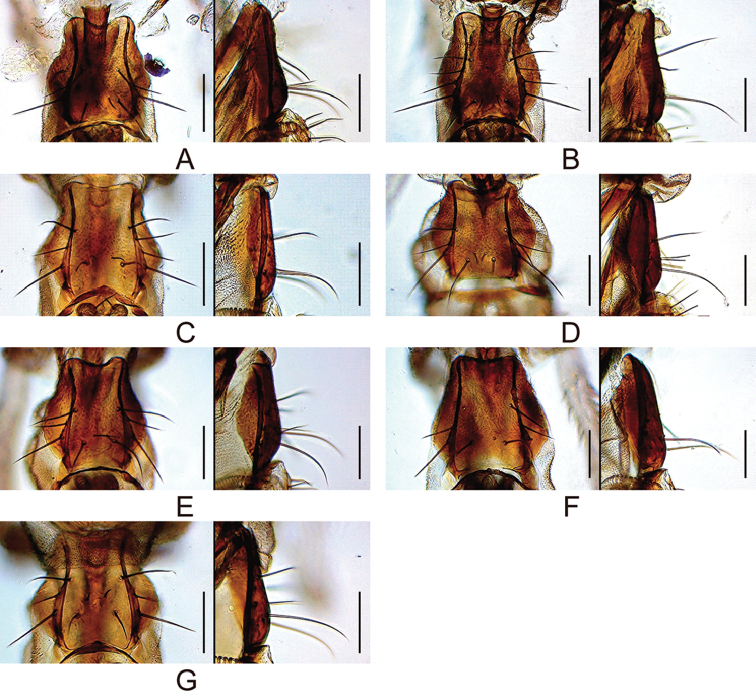
Prementum (ventral and lateral views). Amalayana (Takada) (#03903) Bgracilipalpis sp. n. (paratype #00492) Cpuberula sp. n. (paratype #03366) Dalbipalpis sp. n. (holotype #03908) Eqiongzhouensis sp. n. (paratype #03313) Forthophallata sp. n. (paratype #03905) Gdissimilis sp. n. (holotype #00430). Scale bars: 0.1 mm.